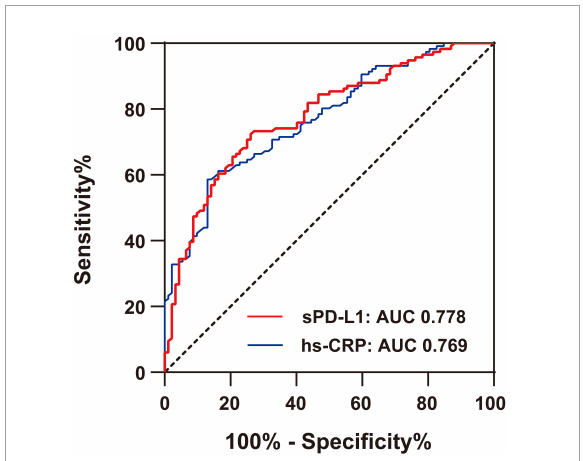
FIGURE5 Comparison of ROC curves for the diagnostic values of hs-CRP and sPD-L1 in ACS. The area under the curve (AUC) of sPD-L1 and hs-CRP in ACS ( n = 92) was indicated, with a sensitivity of 73.9% and a specificity of 72.4% for sPD-L1 and a sensitivity of 79.3% and a specificity of 72.1% for